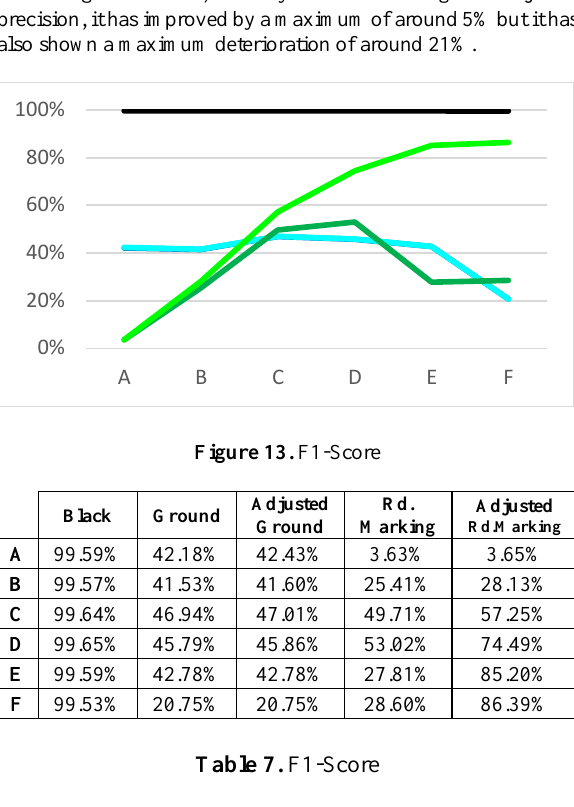
Figure 12. Precision and Adjusted Precision